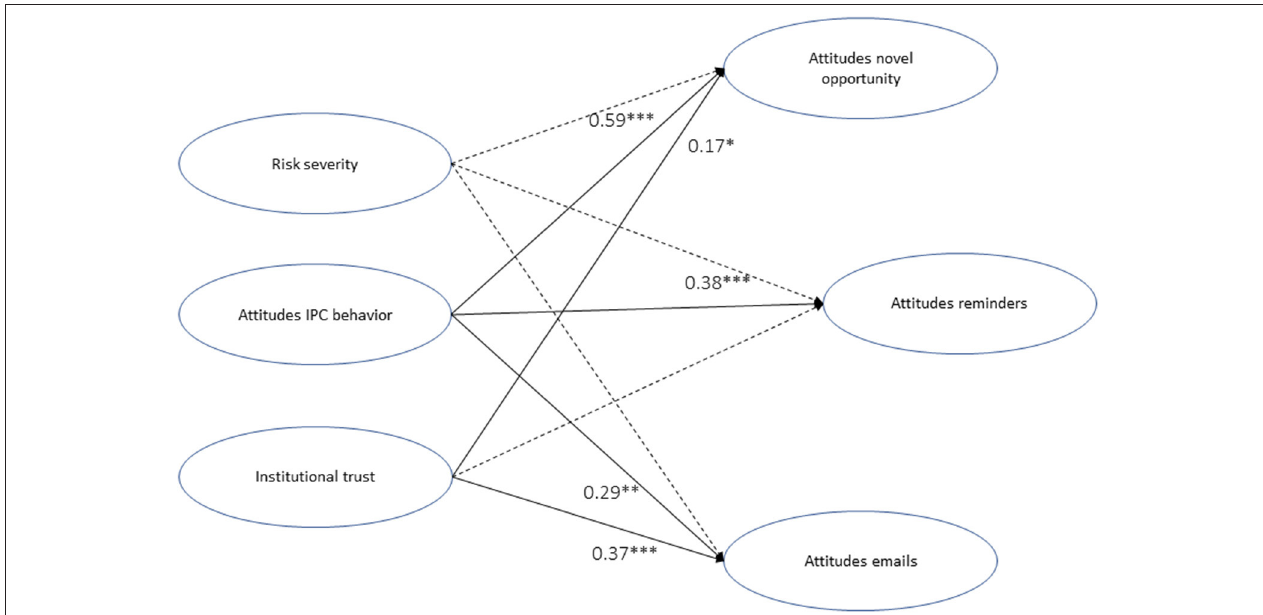
FIGURE 1 | The structural equation model for explaining student perceptions of a Norwegian university’s COVID-19 response strategy. Notes, *** p < 0.001, ** p < 0.01, * p < 0.05. Figure presents standardized estimates. Full lines present significant correlations, dotted lines present non-significant correlations.